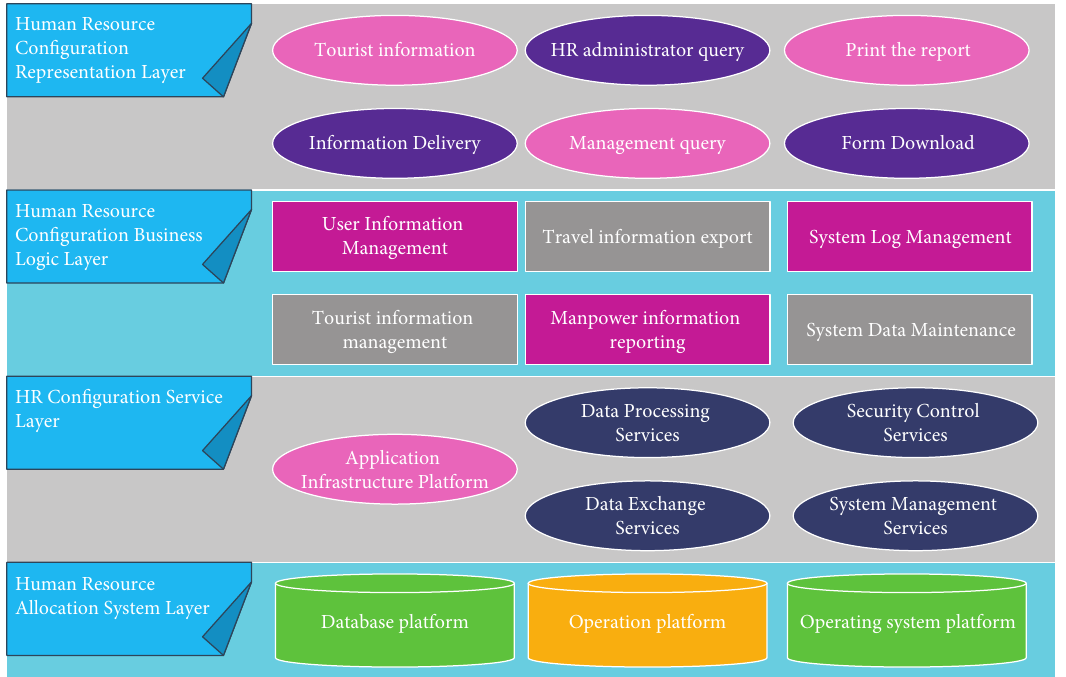
Figure 2: System architecture design diagram.